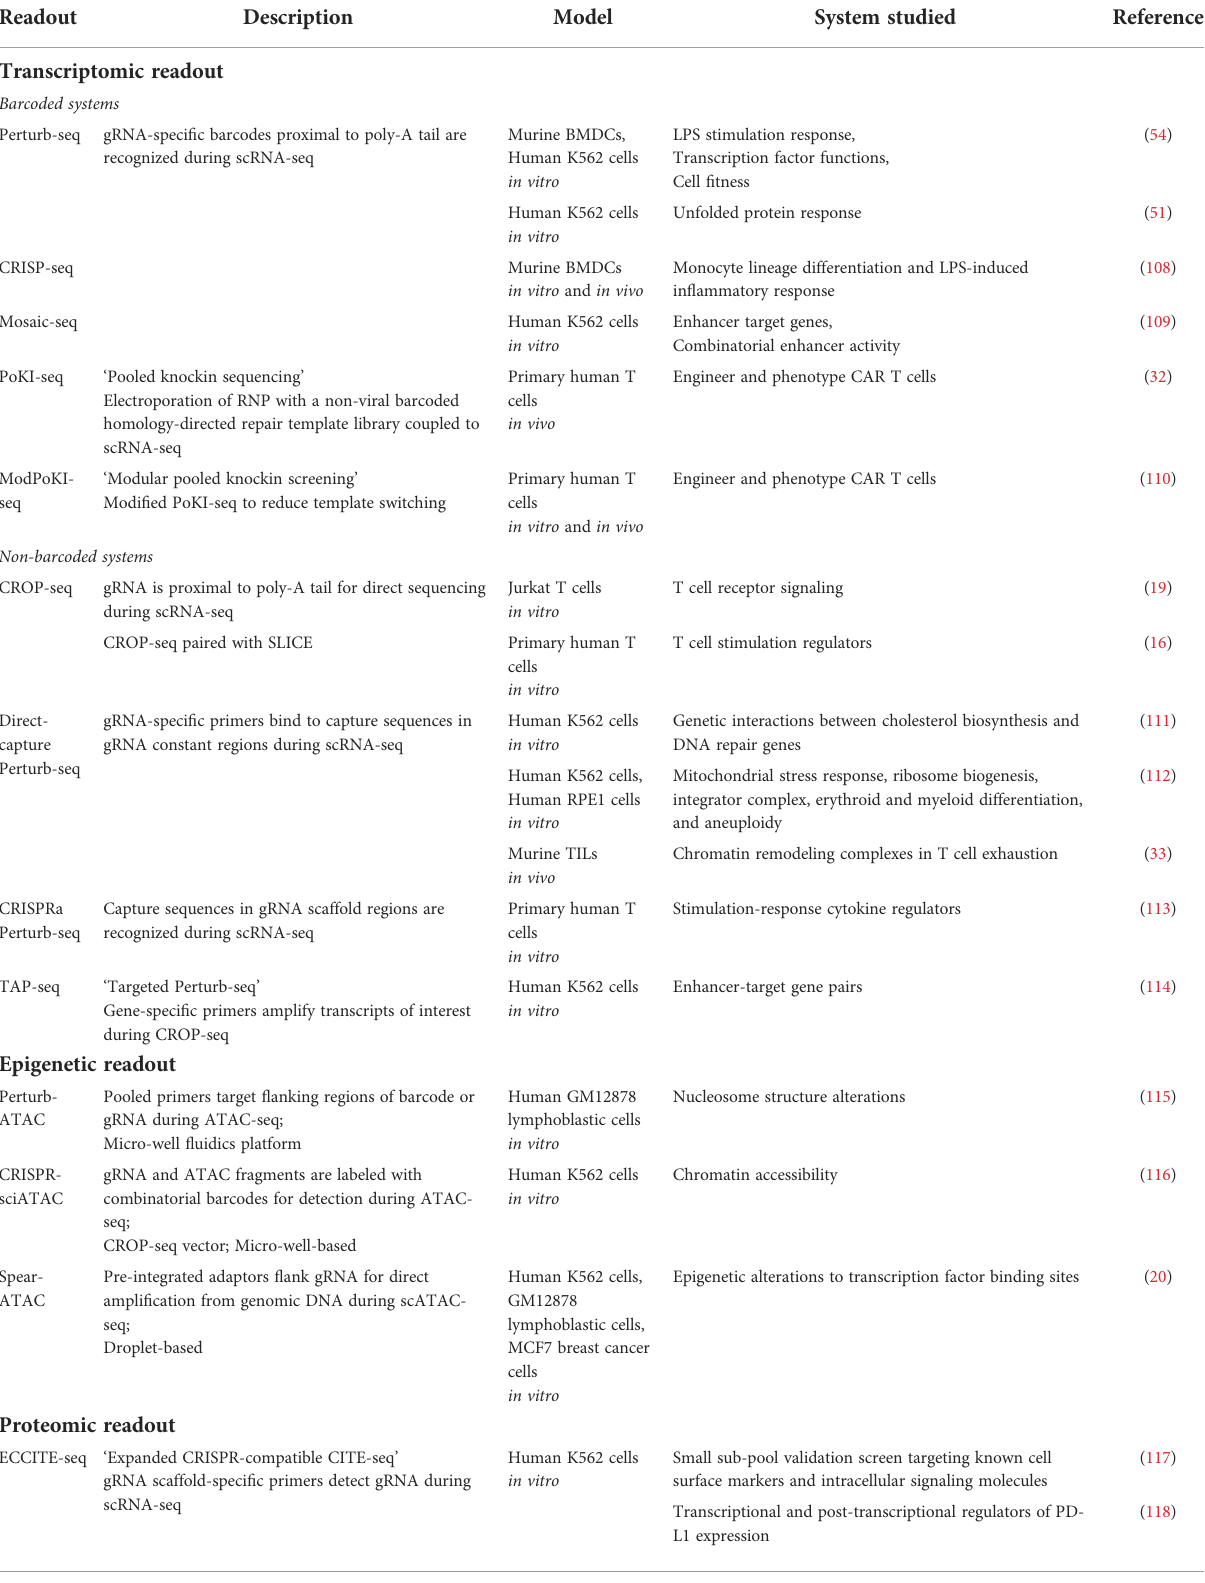
TABLE 1 High-content CRISPR screening